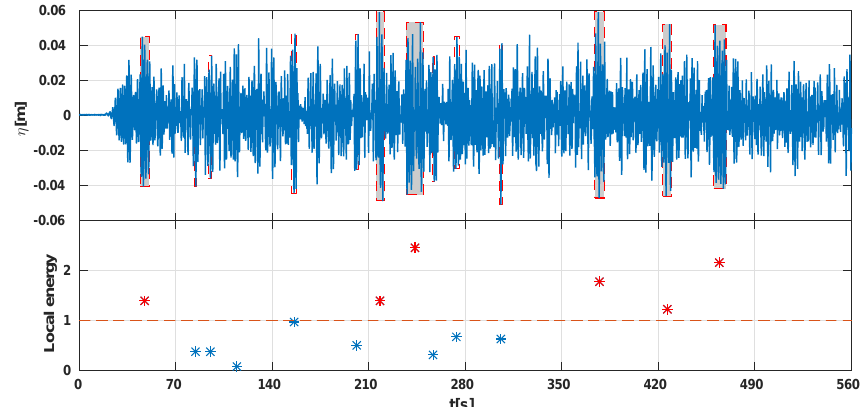
Figure 22. Case IW12. The upper plot shows the influx signal. Four critical group events are shown in the shaded areas. The lower plot shows the local energy signal of group events compared to the local energy threshold (dashed line). The local energy signal of the critical group events are above the threshold.